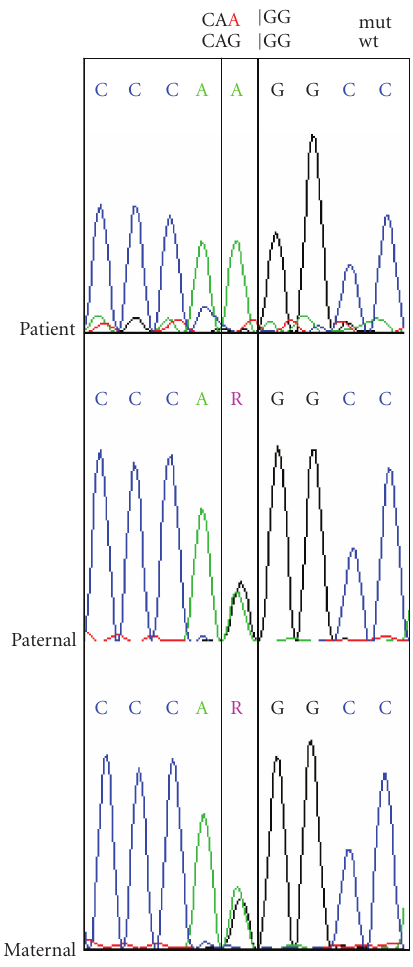
Figure 10: Sequence analysis of 3760-1G > A in COL7A1. The patient is homozygous for this mutation, and parental heterozygous alleles confirm the genetic